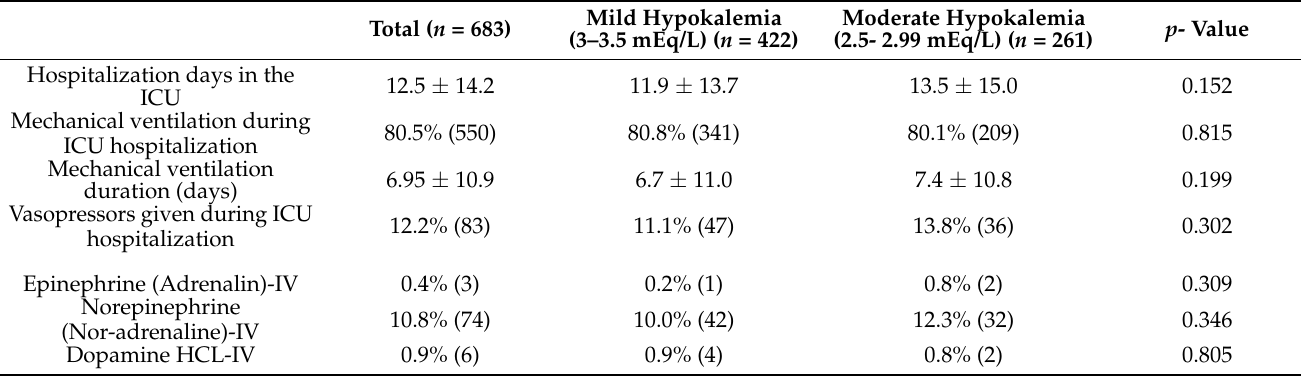
Table 2. Characteristics of hospitalizations in the intensive care